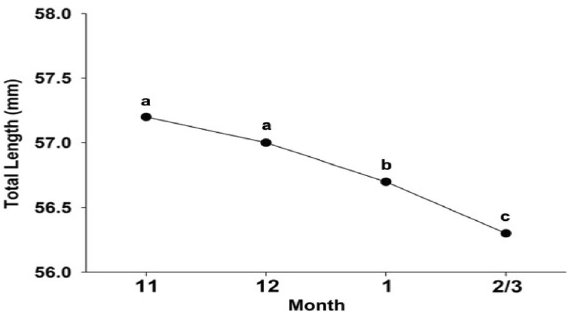
Figure 4. The mean total length of Japanese glass eels from Taiwan (November to